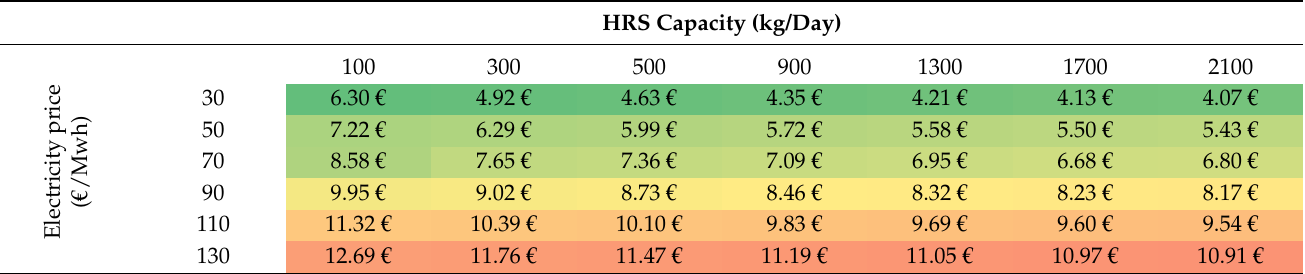
Table 8. LCOH sensitivity analysis for on-site production, varying the HRS capacity (kg/day) and the electricity price ( € /MWh). In green the lowest cost solutions, in red the